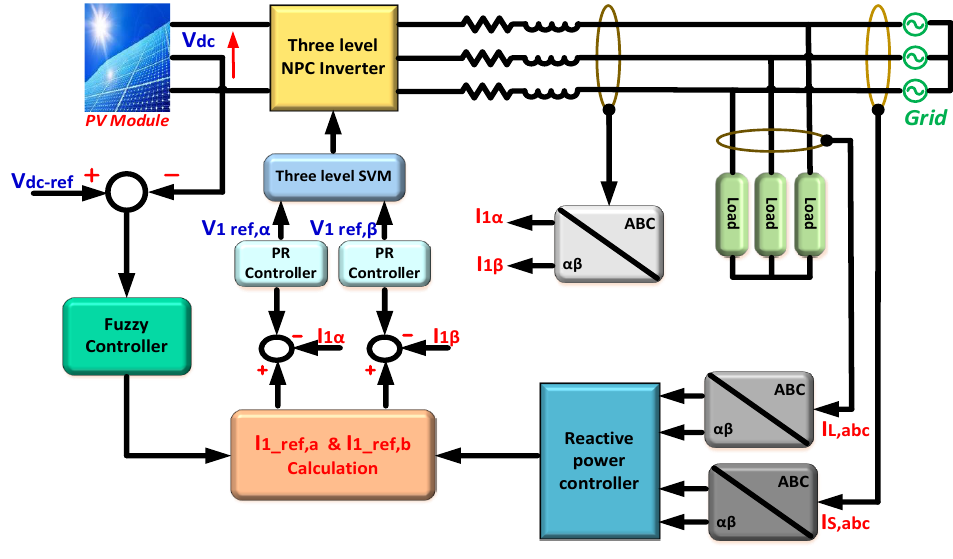
Figure 11. Voltage-oriented control (VOC) [135].